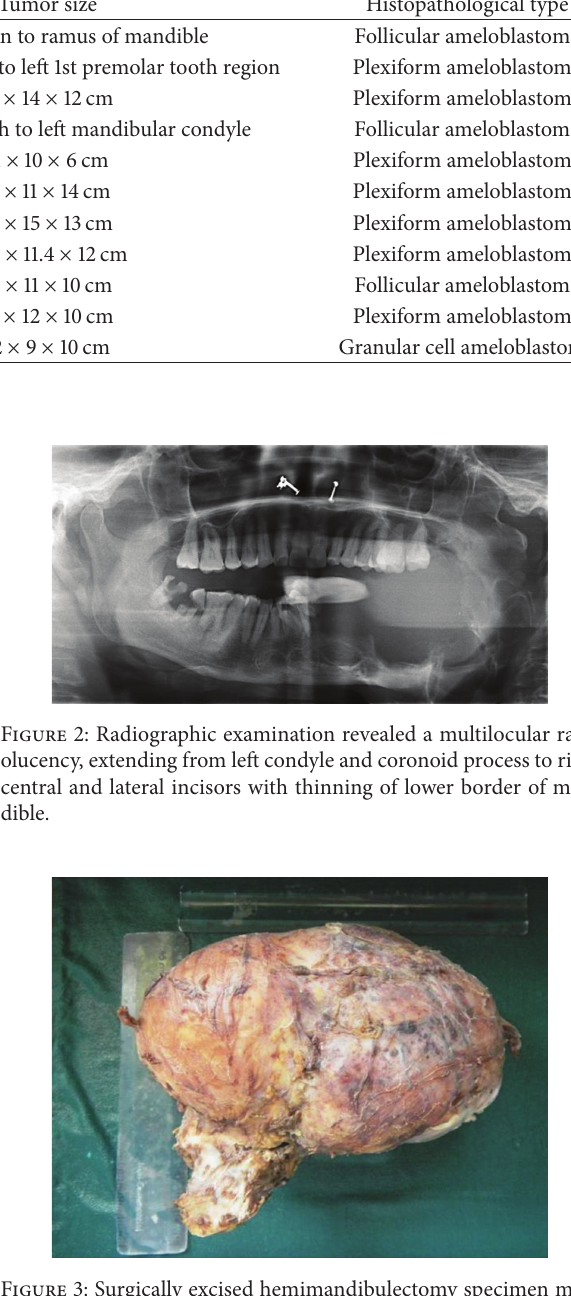
Figure 3: Surgically excised hemimandibulectomy specimen mea- sured 12 × 9 × 10